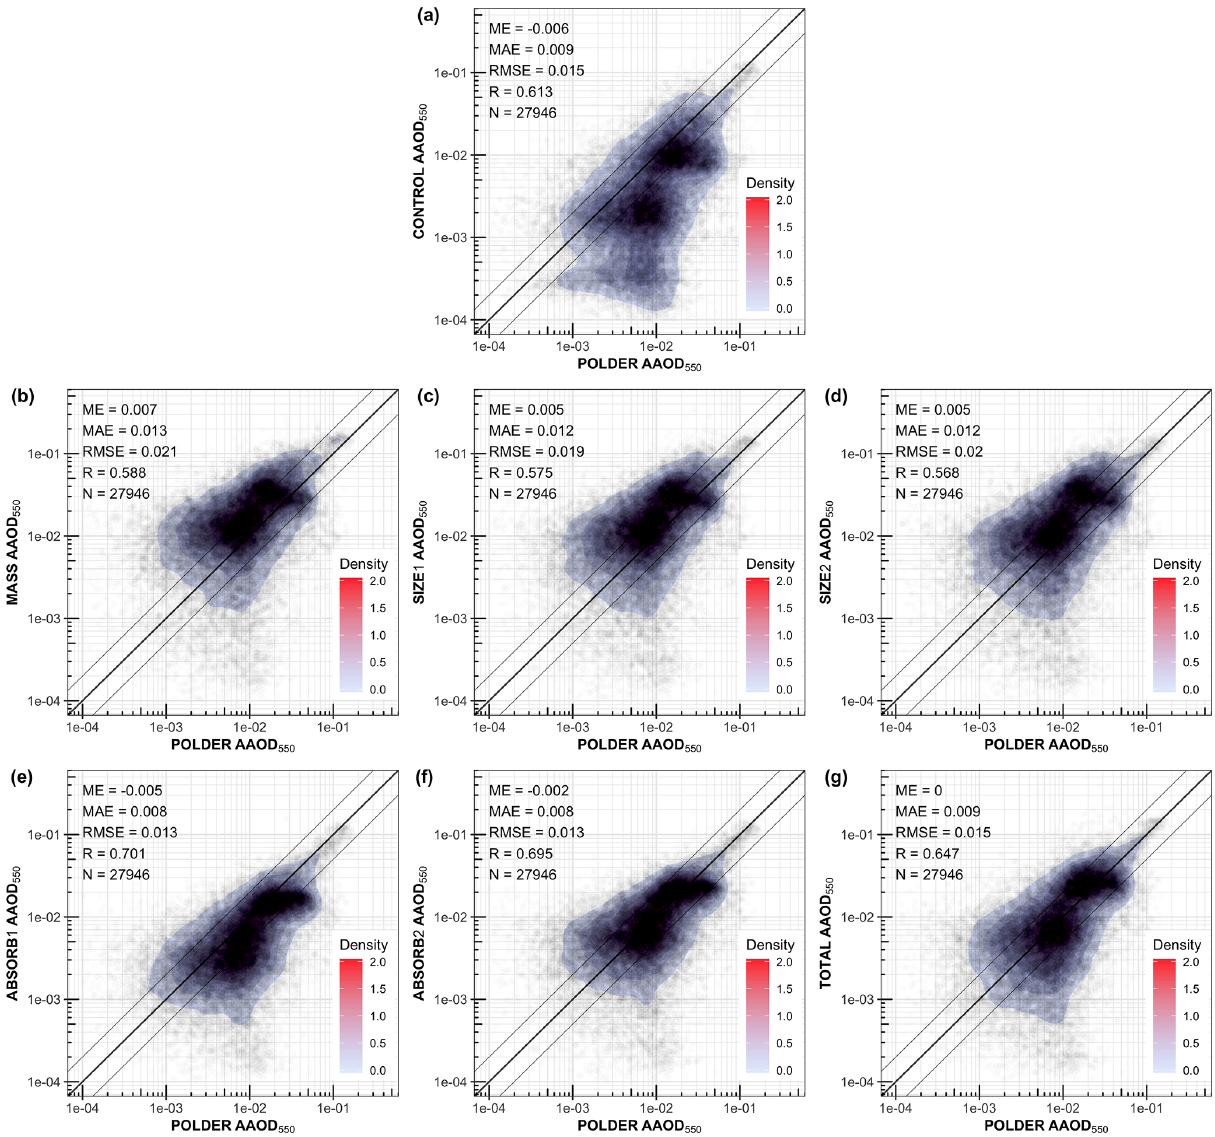
Figure 11. Similar to Fig. 6 but for aerosol absorption optical depth at 550nm.